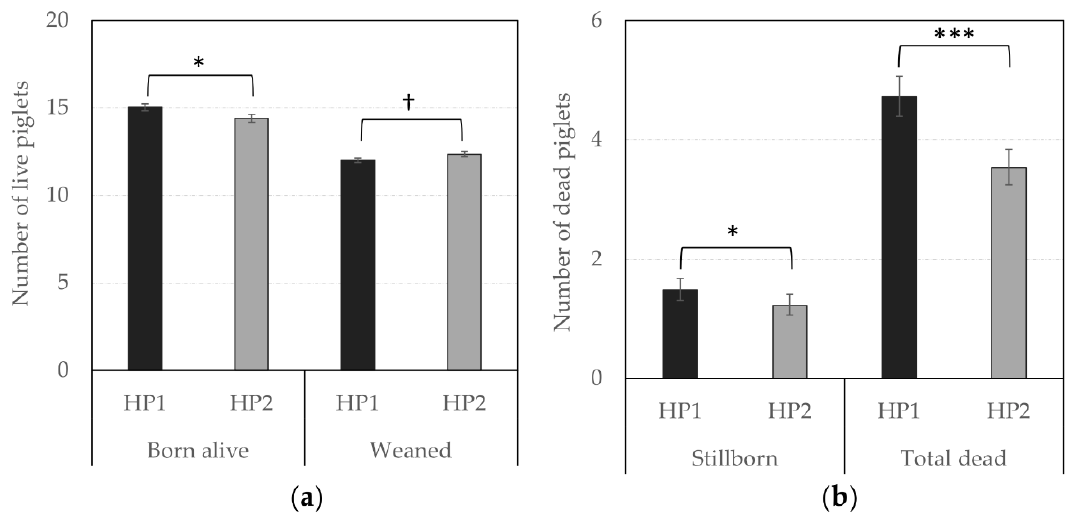
Figure 4. ( a ) Average (± SEM) number of born alive and weaned piglets and, ( b ) Back-transformed predicted mean (CI) number of stillborn and total dead piglets according to genetic line. *, *** Means differ significantly (* p < 0.050, *** p < 0.001); † Means tend to differ ( p < 0.10) between genetic lines.